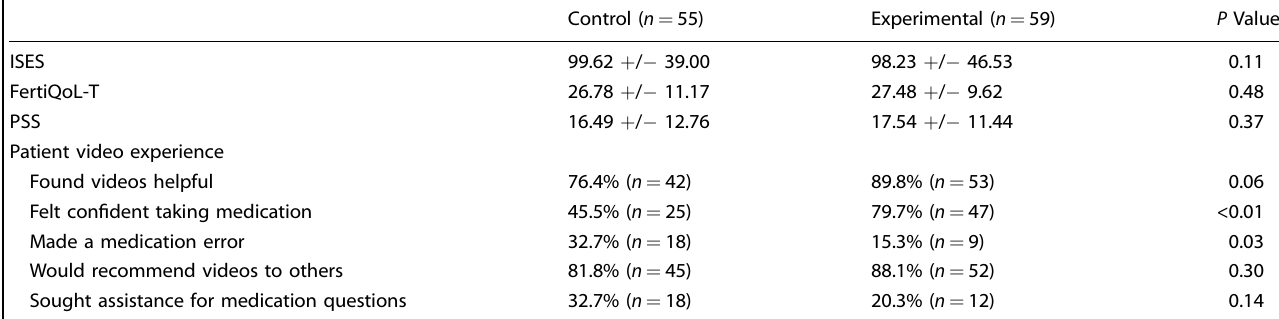
Table 3. Outcomes from per protocol